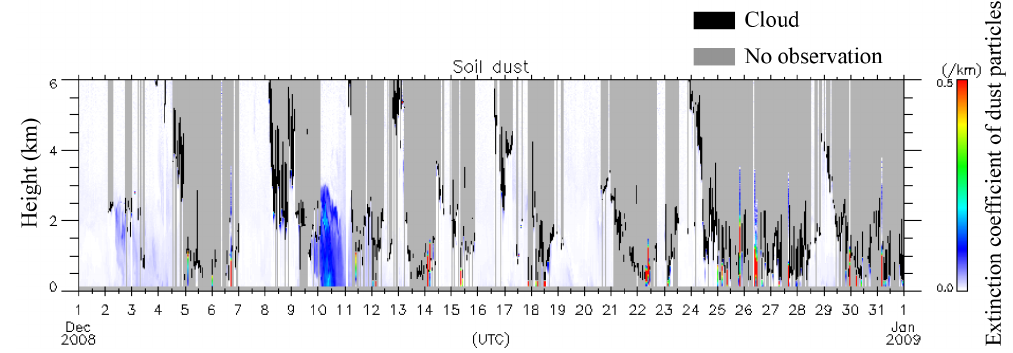
Figure 2. Example of lidar measurements of dusts obtained at Imizu, Toyama (ca. 40km northwest of Mt. Tateyama) during 1–31 December 2008. The color scale indicates the extinction coefficient of dust particles based on lidar measurements. Black line represents clouds and gray shade above the black lines represents no data.